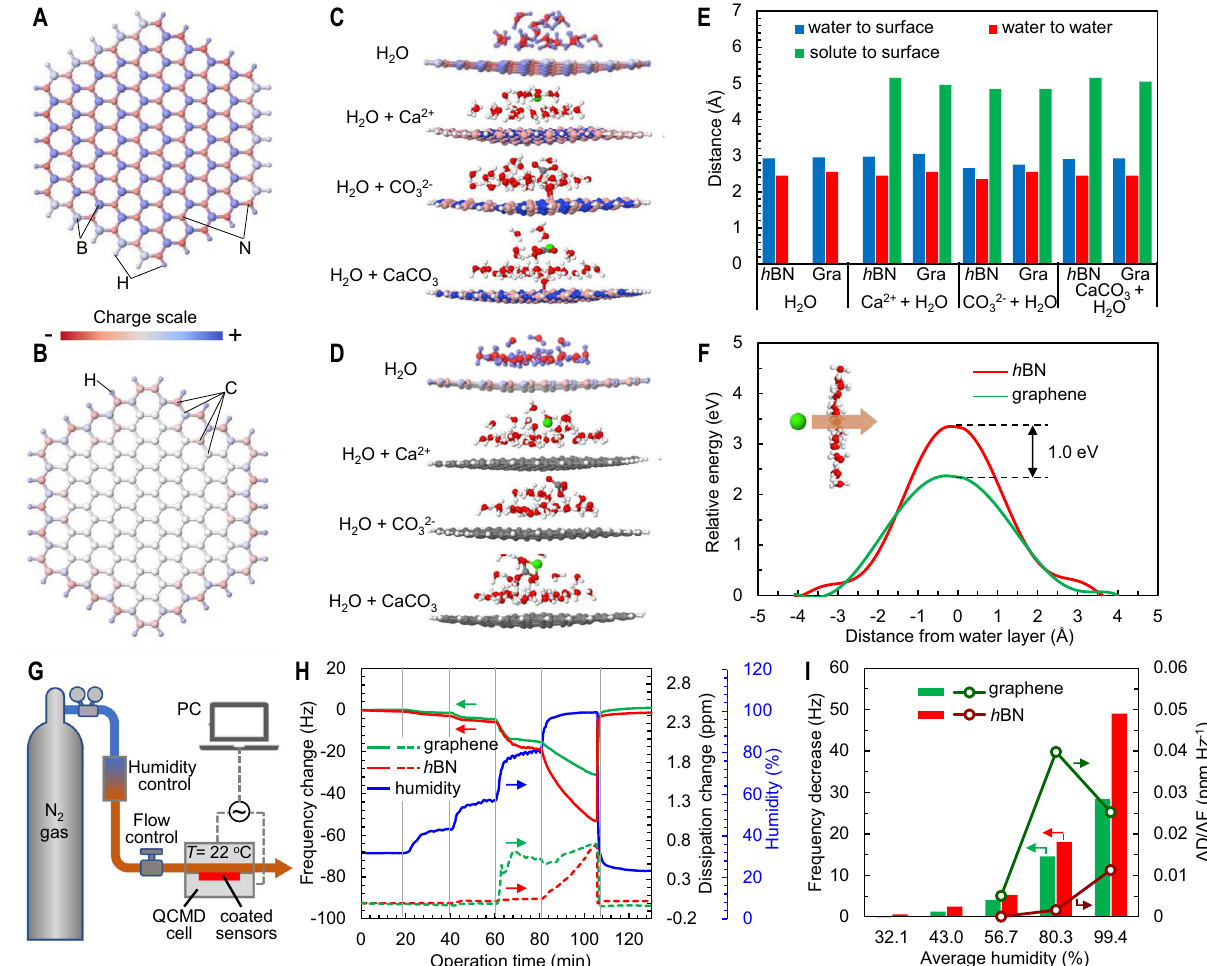
Fig.4|EffectofsurfacechemistryonnucleationbehaviorofCaCO 3 on h BNand graphene surface. DFT simulated charge distribution on A h BN and B graphene surfaces. Blue and red spheres in A represent boron and nitrogen atoms, respec- tively. Silver, light blue, and light red spheres in B represent carbon atoms (Sup- plementaryFig.7).Theedgeofboth h BNandgraphene fl akesarepassivatedwithH atoms; DFT simulated interaction of H 2 O, Ca 2+ , CO 3 2 − , and CaCO 3 with C h BN and D graphene surface (Supplementary Fig. 11); E DFT calculated distance between water and surface, between water molecules, and between solutes (Ca 2+ , CO 3 2 − , or CaCO 3 ) and h BN or graphene surfaces. Gra: graphene; F Minimum energy